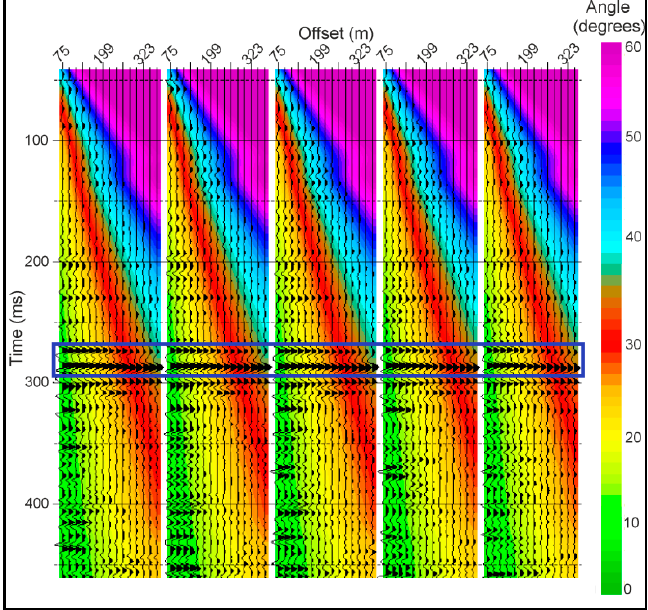
Figure 9. The angle of incidence overlaid on conditioned offset gathers. The zone of interest is indicated by the blue rectangle.